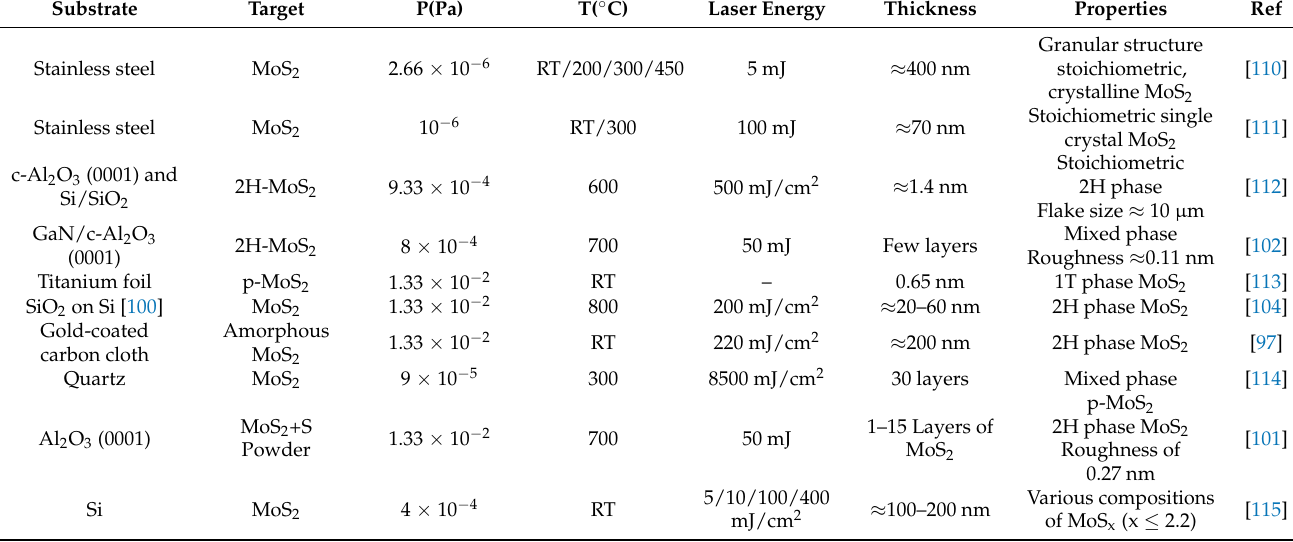
Figure 3. Schematic of the pulsed laser deposition chamber. Table 5. Summary of the PLD conditions of MoS 2 films along with their thickness and some of their properties.